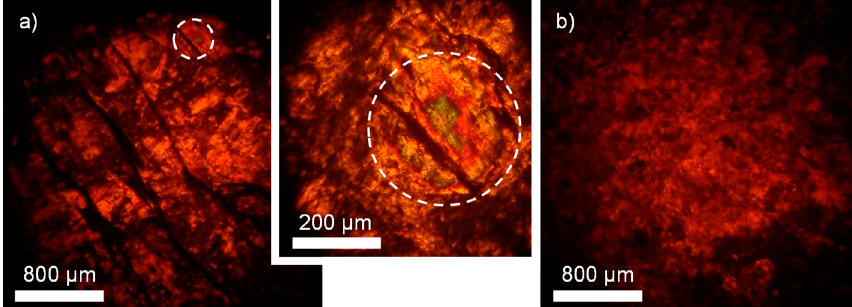
Figure 5. Images of the Co 2 Al–CO 3 samples in a polarized microscope: the pressed compact of the LDH powder precipitated in an external magnetic field and then dried without mixing ( a ) and the pressed compact of the LDH powder dried after centrifugation ( b ). Inset shows the magnified image of the zone with the iridescent colors.